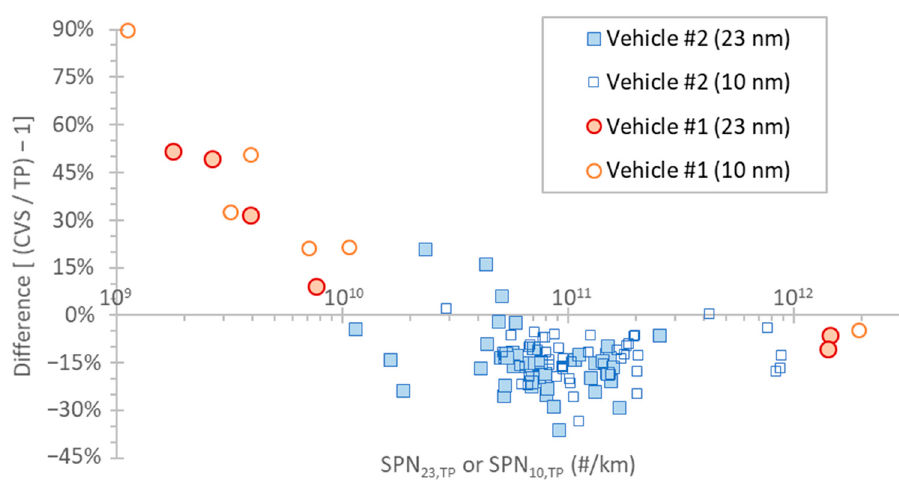
Figure 3. Differences between the SPN instruments at the dilution tunnel (CVS) and the tailpipe (TP). Results from vehicle #1 (Euro 6d-Temp) are plotted with circles and from vehicle #2 with squares (Euro 6b). Solid symbols are the results from the 23 nm counters, while open symbols from the 10 nm counters.